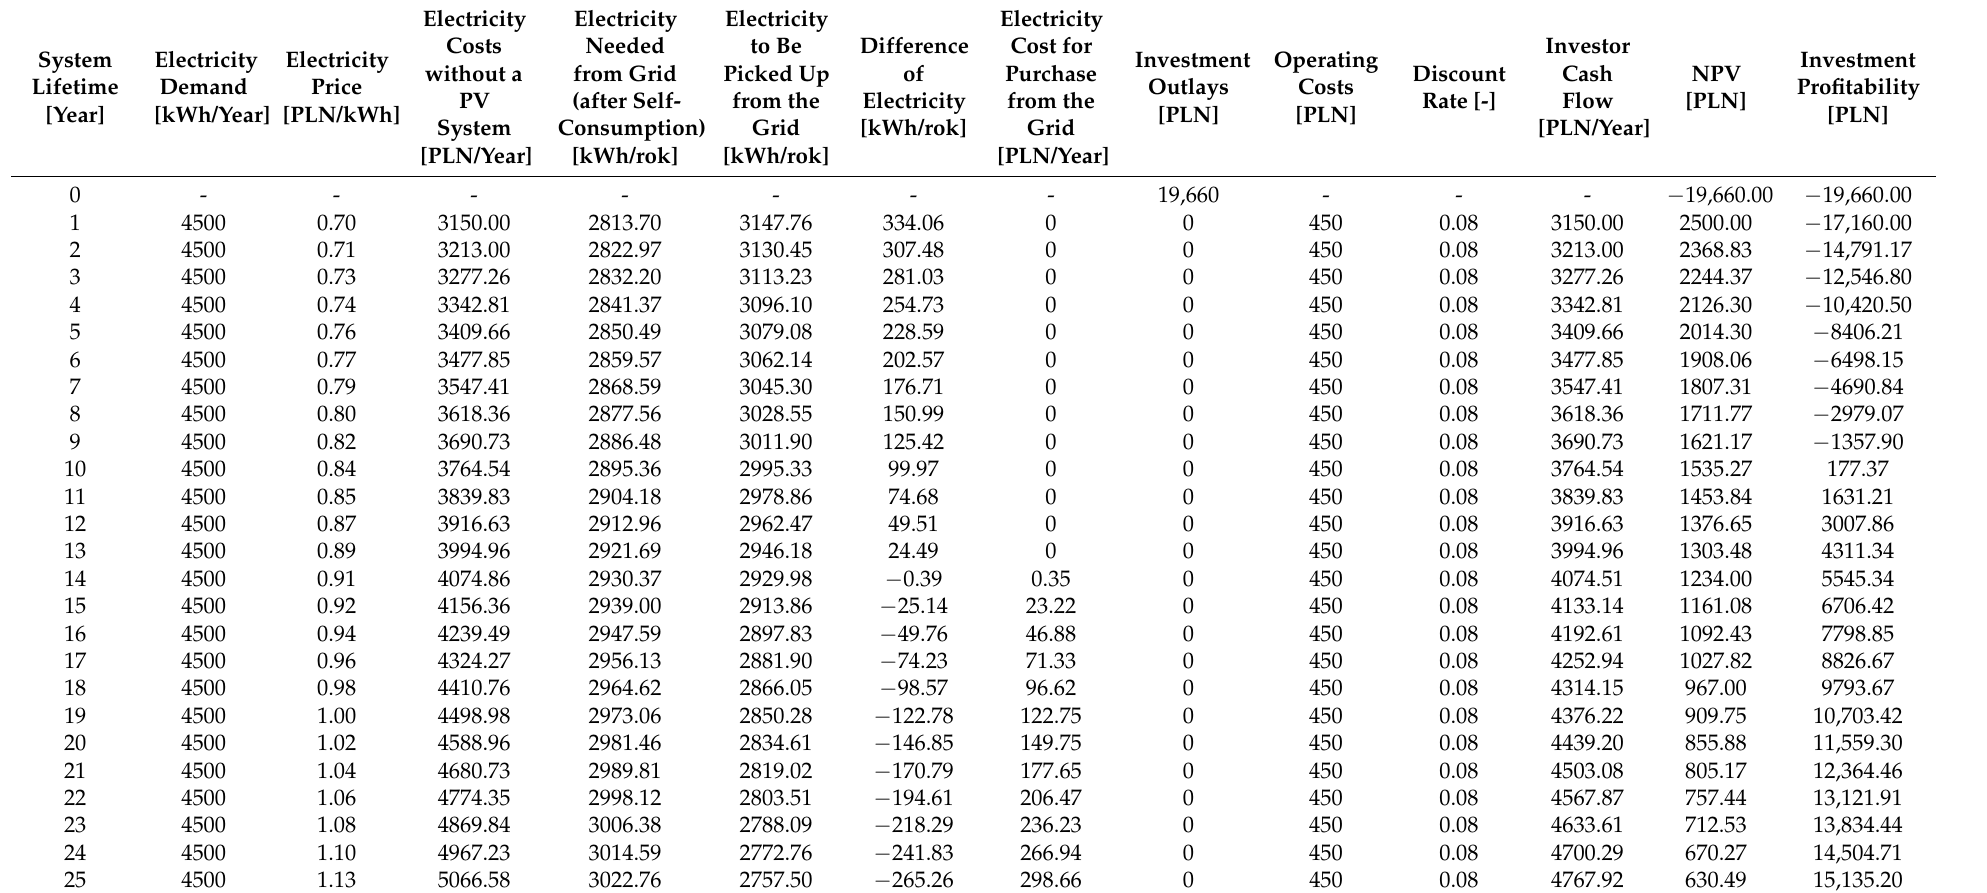
Table A1. NPV results of the PV installation for the discount system, at a 30% self-consumption